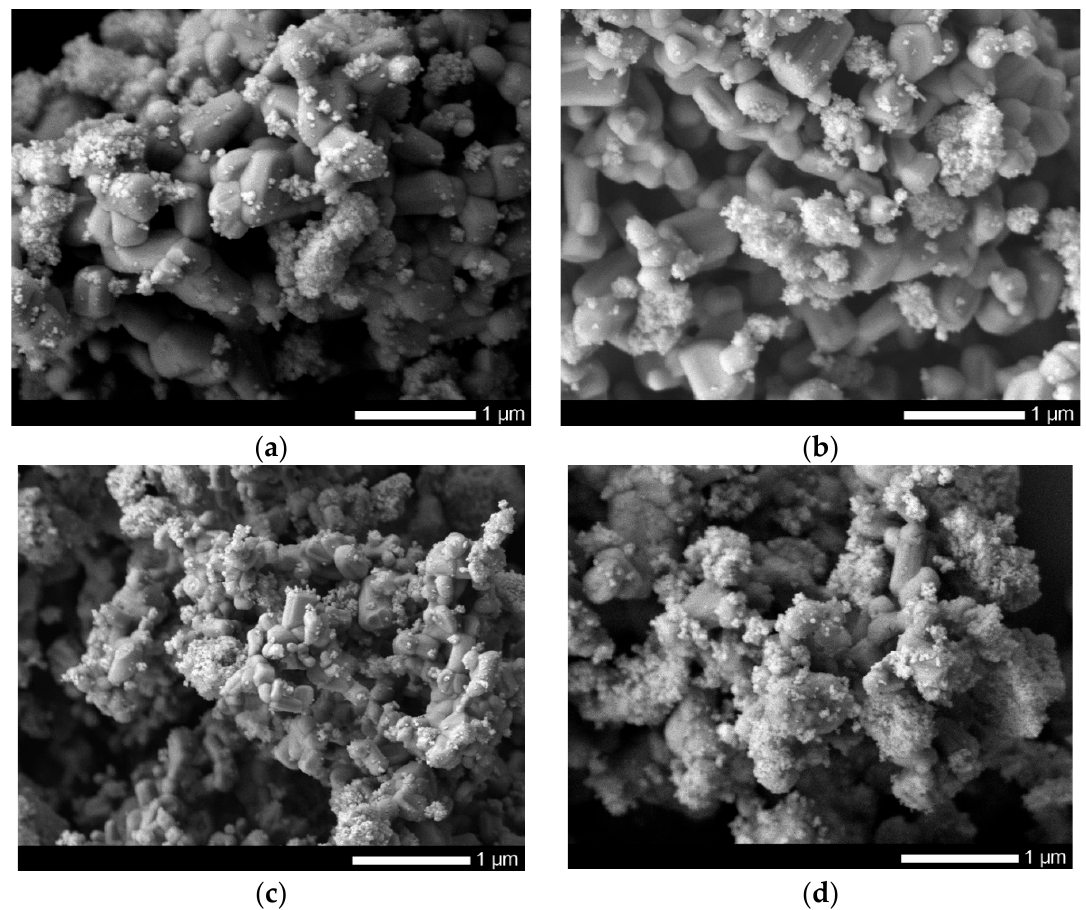
Figure 13. SEM images of synthesized nanoparticles after separation: ( a ) FeCeO x nanoparticles; ( b ) 0.9FeCeO x + 0.1Nb 2 O 5 nanoparticles; ( c ) 0.8FeCeO x + 0.2 Nb 2 O 5 nanoparticles; and ( d ) 0.7FeCeO x + 0.3 Nb 2 O 5 nanoparticles.